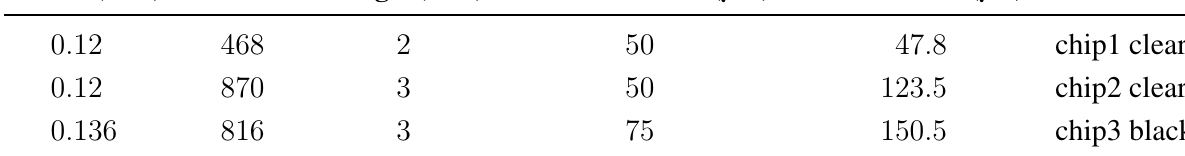
Table 1. Geometric parameters of integrated capillary tubes and total flow volumes. The designed radius and center distance were 0.1 and 0.36 mm, respectively. The flow volume is the calculated